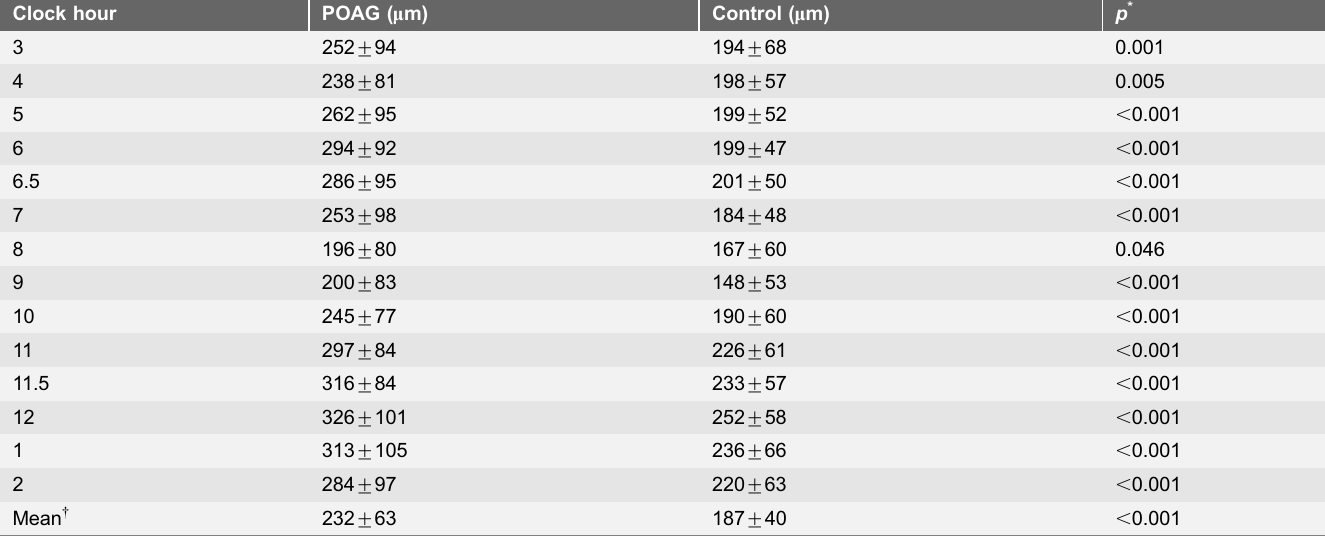
Table 5. Comparison of mALCSD between POAG patients and normal healthy (control) subjects.